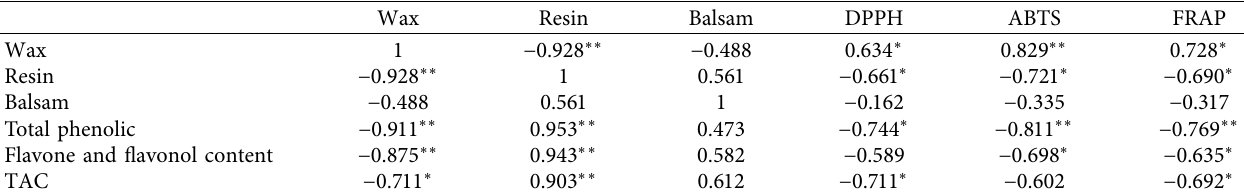
Table 3: Pearson correlation coefficients between the analyzed parameters and antioxidant activity.